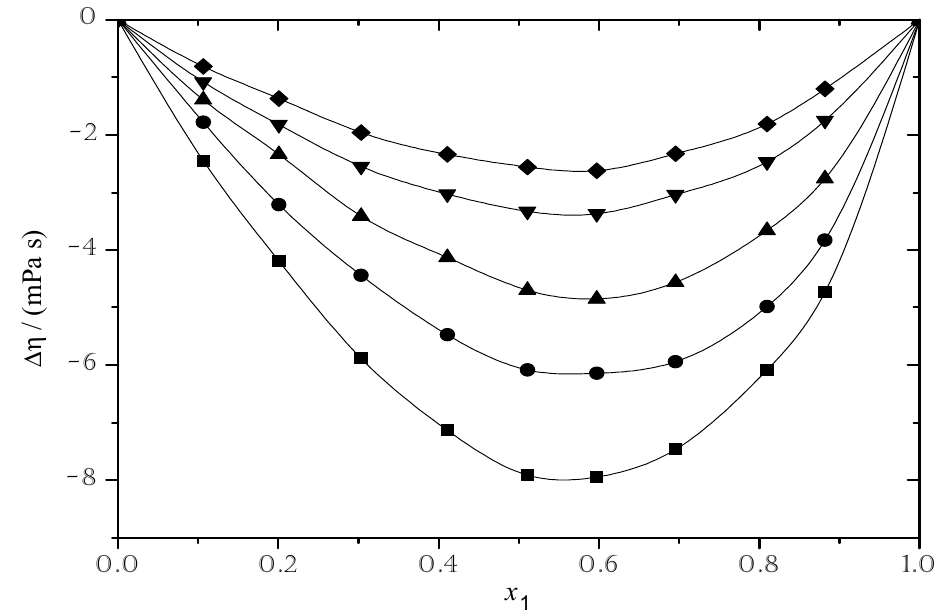
Figure 3. Viscosity deviation ( Δ η ) with mole fraction for DEG (1) + DMSO (2) system at various temperatures: ■ 293.15 K; ● 298.15 K; ▲ 303.15 K; ▼ 308.15 K; ♦ 313.15K.